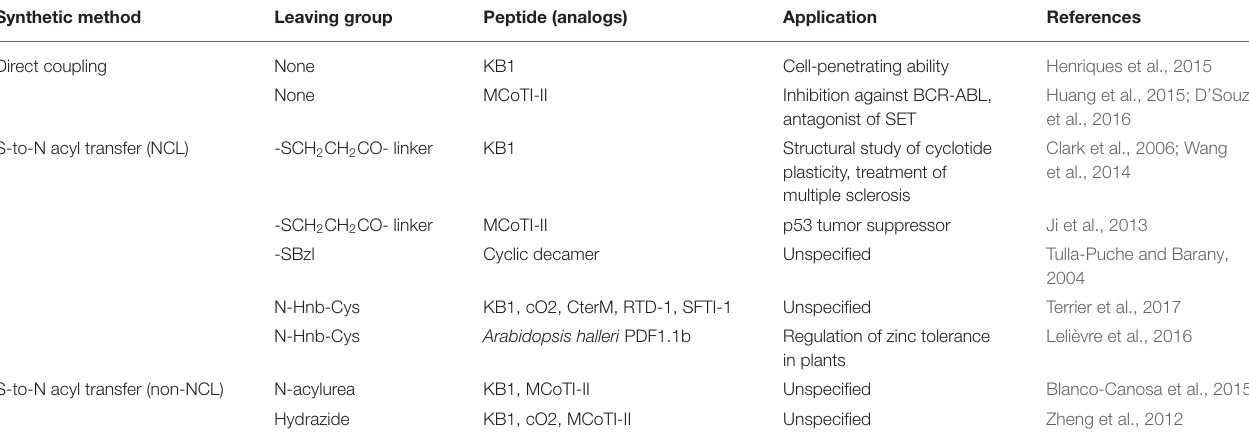
TABLE 1 | Examples of backbone macrocyclic peptides synthesized with various